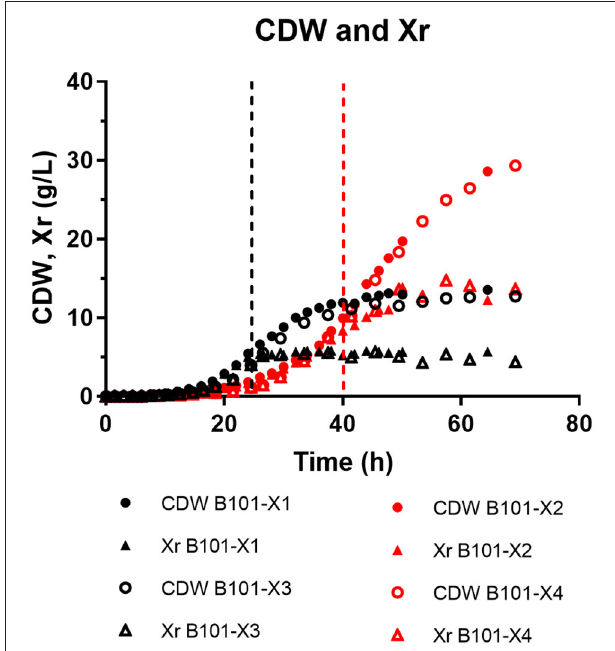
FIGURE 1 | Cell dry weight (CDW) and residual biomass (Xr) (both in g/L) obtained for each fed-batch cultivation. B101-X1 and B101-X3 refer to experiments under nitrogen limitation (black dots/lines), while B101-X2 and B101-X4 refer to experiments under phosphorus limitation (red dots/lines).